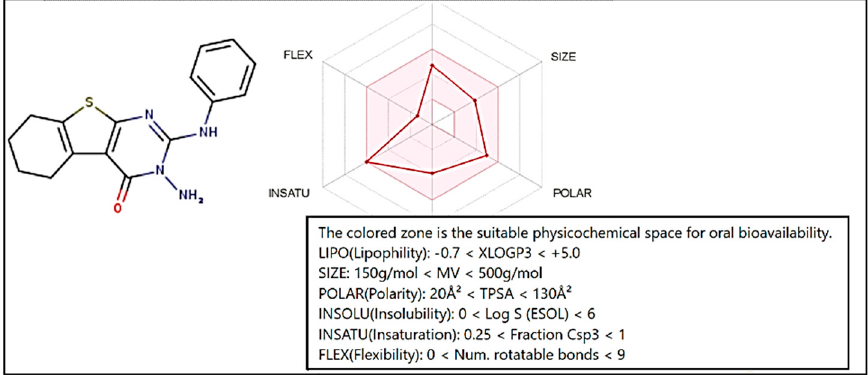
Figure 5. Oral bioavailability represented in the red zone for the compound under investigation. Table 3. Pharmacokinetics data and drug likeness value for the tested compound.